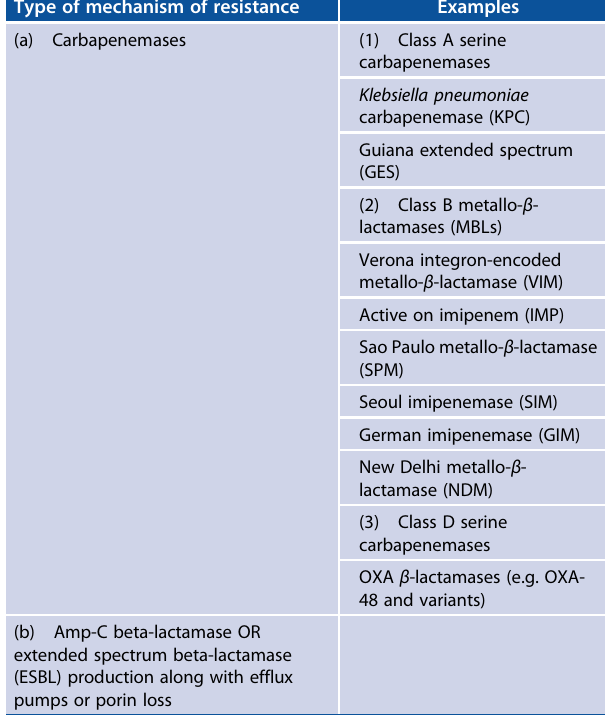
Table 1: The plasmid-mediated mechanisms of resistance Type of mechanism of